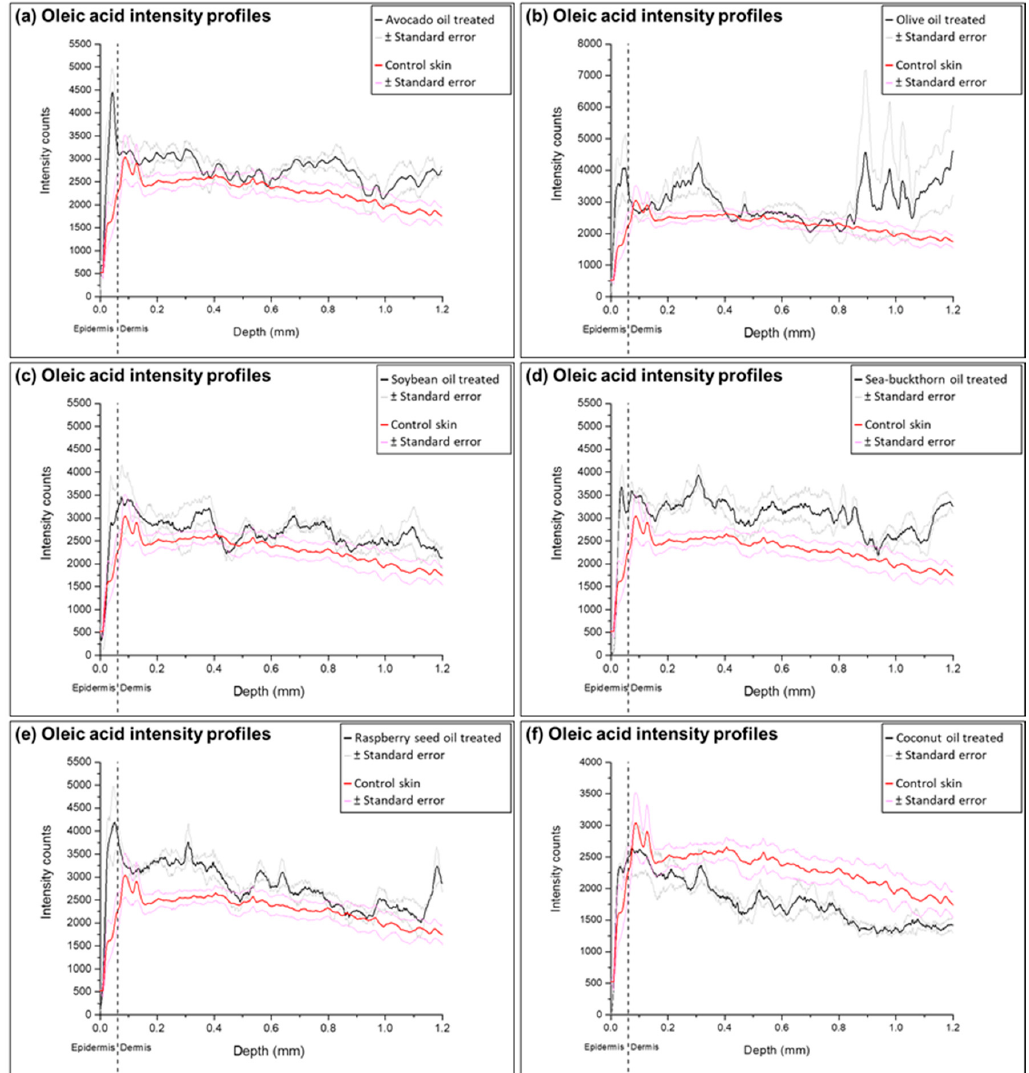
Figure 5. Ion intensity profiles for oleic acid detected in samples treated with natural oils and compared to the intensity profiles of the control: ( a ) avocado oil; ( b ) olive oil; ( c ) soybean oil; ( d ) sea-buckthorn pulp oil; ( e ) raspberry seed oil; ( f ) coconut oil. The intensity profile of treated samples is shown as a solid black line, and solid red line indicates the control. Similar fluctuations are visible in all FA